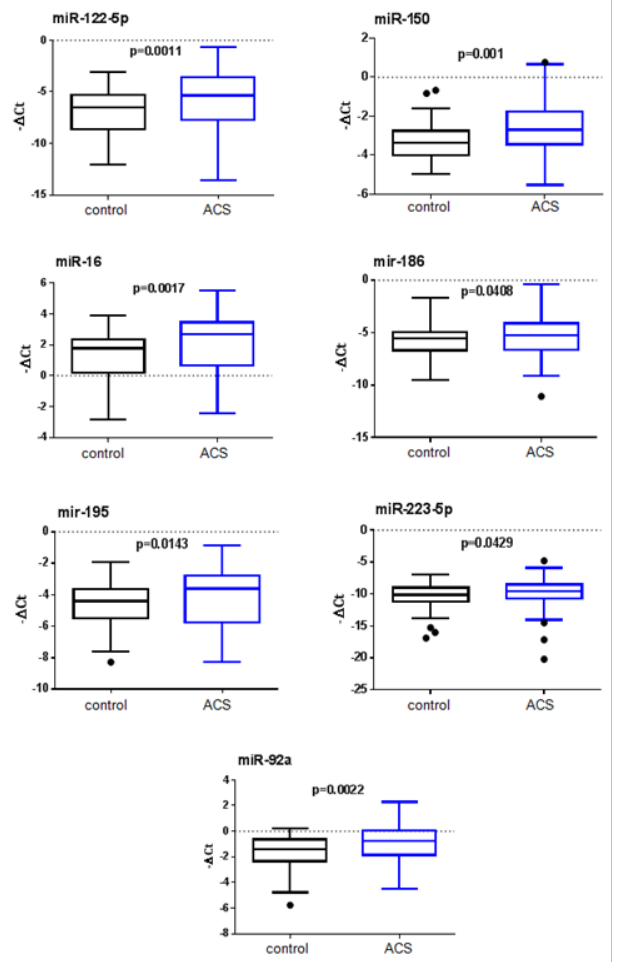
Figure 2. Plasma miRNA levels in the validation population. The box plots show the expression levels of miR-122-5p, miR-150, miR-16, miR-186, miR-195, miR-223-5p and miR-92a measured by RT-qPCR in ACS (n = 80) and control subjects (n = 80). The dots represent the outlier values plotted as individual points. The relative miRNA expression levels were normalized to cel-miR-39 and calculated by −ΔCt.